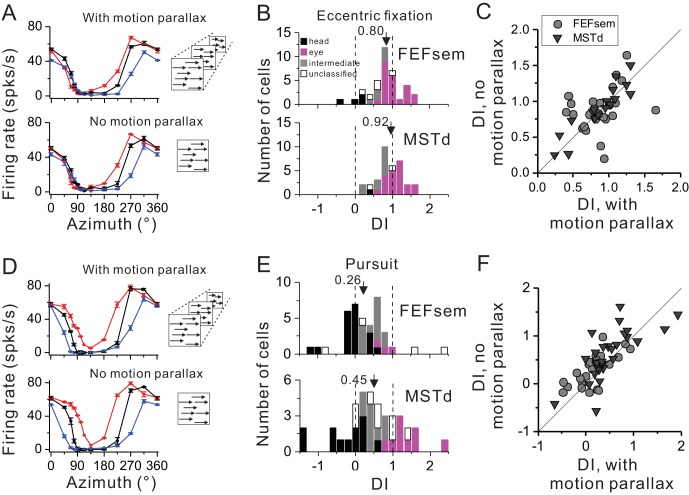
Influence of motion parallax on spatial reference frame (A–C) and pursuit compensation (D–F) measurements.(A) Visual tuning functions of an example FEFsem neuron with and without motion parallax in the optic flow. Red, black and blue curves represent eccentric fixation at −20°, 0° and 20°, respectively. (B) Distribution of DI without motion parallax cue in FEFsem (upper panel, N = 38) and MSTd (bottom panel, N = 34). Black bars: head-centered coordinate; Magenta bars: eye-centered coordinate; Gray bars: intermediate coordinate; Open bars: unclassified coordinate. Arrowheads indicate the mean value. (C) Direct comparison of DIs between with and without motion parallax cues on a cell by cell basis. Each symbol represents a neuron. Circle: FEFsem, N = 27; Triangle: MSTd, N = 17. (D–F) Same format as in (A–C) but for the pursuit protocol. Red, black and blue curves represent rightward, fixation only (no-pursuit) and leftward pursuit, respectively. In (E), for FEFsem, N = 39; for MSTd, N = 38; In (F), for FEFsem, N = 24; for MSTd, N = 29.10.7554/eLife.29809.014Figure 5—source data 1.Raw data for Figure 5B.10.7554/eLife.29809.015Figure 5—source data 2.Raw data for Figure 5E.